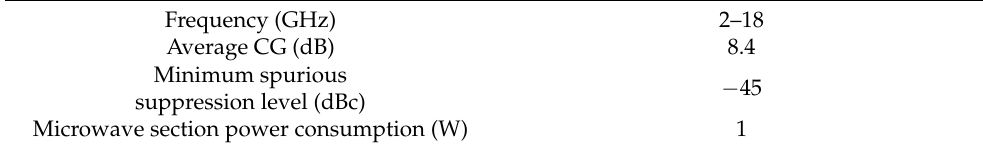
Table 2. The main performance of the reported downconverter.